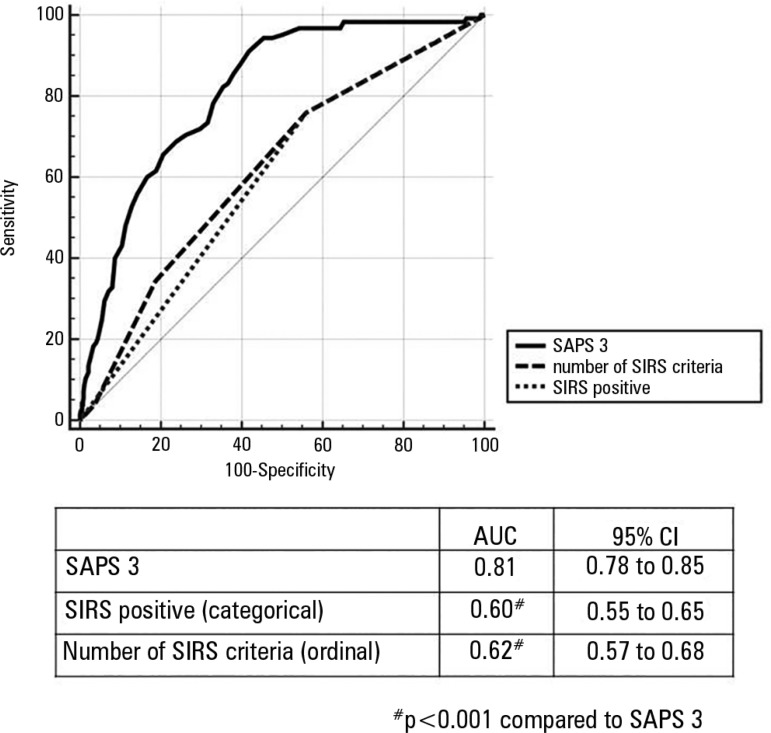
Receiver operating characteristic curves for the prediction of hospital
mortality.AUC - area under the curve; CI95% - confidence interval 95%; SAPS 3 -
Simplified Acute Physiology Score 3; SIRS - systemic inflammatory
response syndrome.